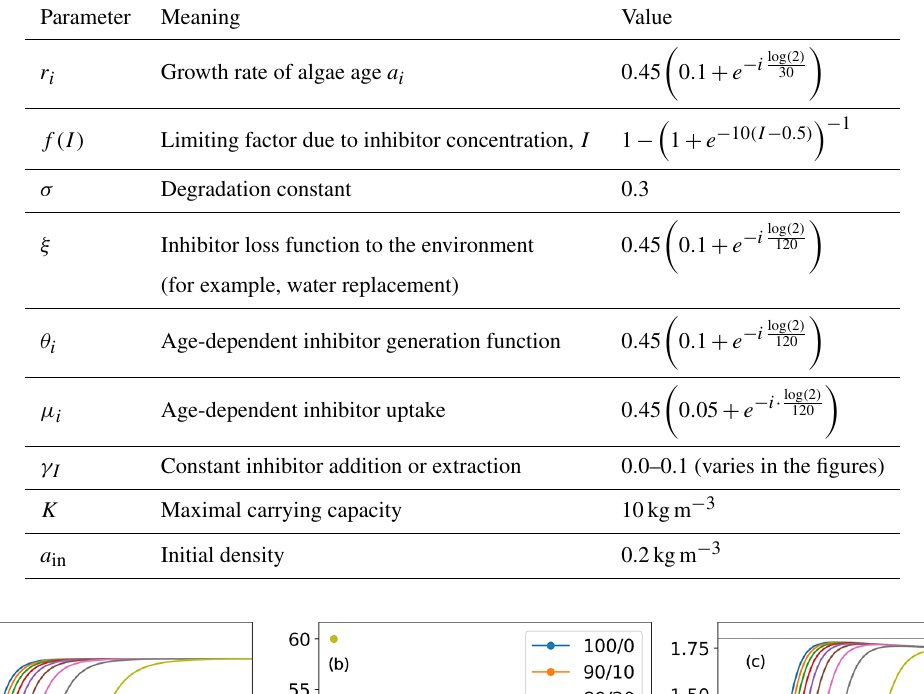
Table 1. Model parameters, their interpretation and values.